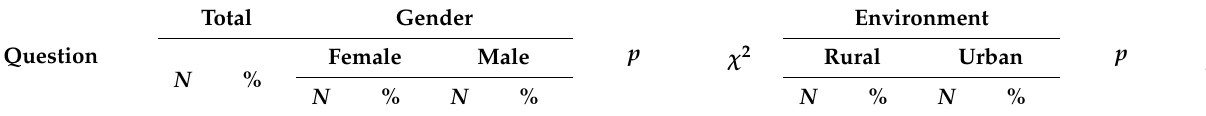
Table 1. Distribution of responses regarding control of airborne